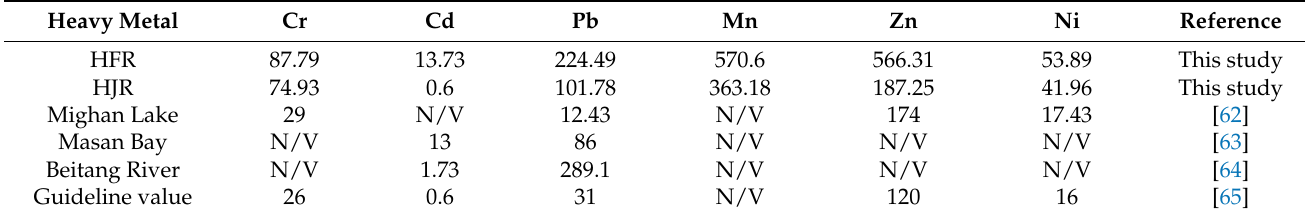
Table 4. Heavy-metal concentration (mg · kg − 1 ) in surface sediments.